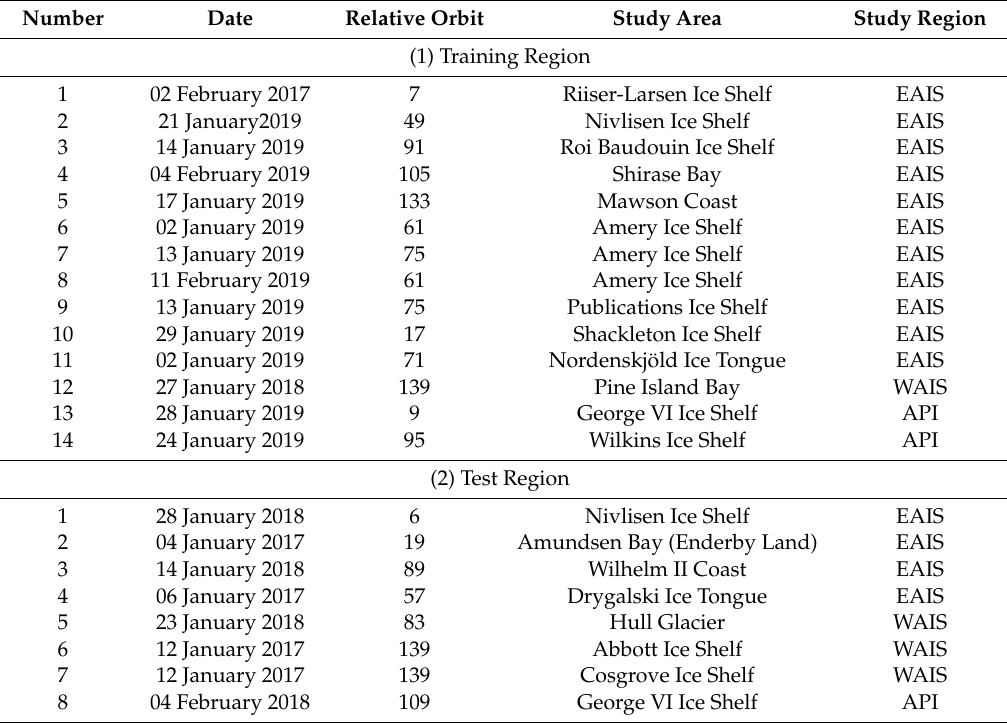
Figure 3. Overview maps of the study regions. ( a ) Distribution of training (blue) and test (red) sites across the Antarctic continent. ( b ) Spatial coverage of Sentinel-2 acquisitions covering the Amery Ice Shelf during the 2017, 2018, 2019 and 2020 melt seasons as well as their overlap area and Region of Interest (ROI) 1. GL = Grounding Line. The coastline data were downloaded from the SCAR Antarctic Digital Database (ADD) [50]. Table 1. Sentinel-2 data used for training and test